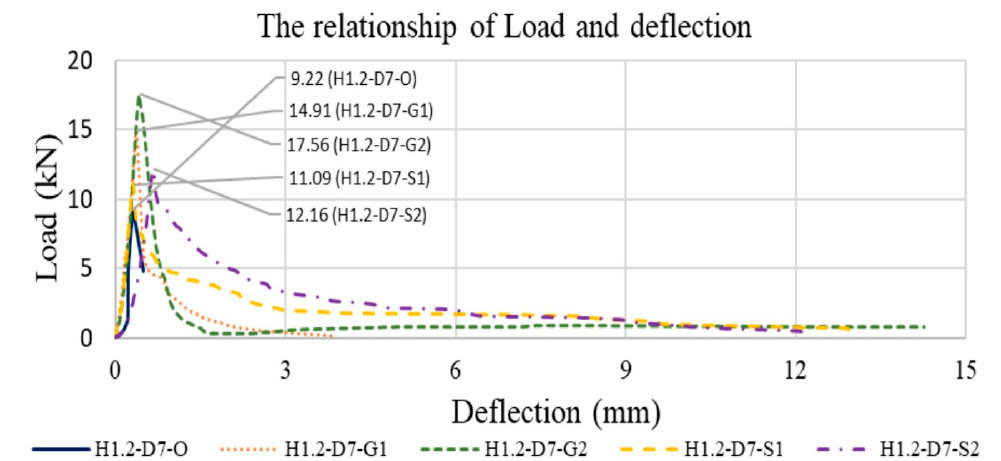
Figure 17. Flexural load and displacement diagram for H1 high-strength fiber pervious concrete.